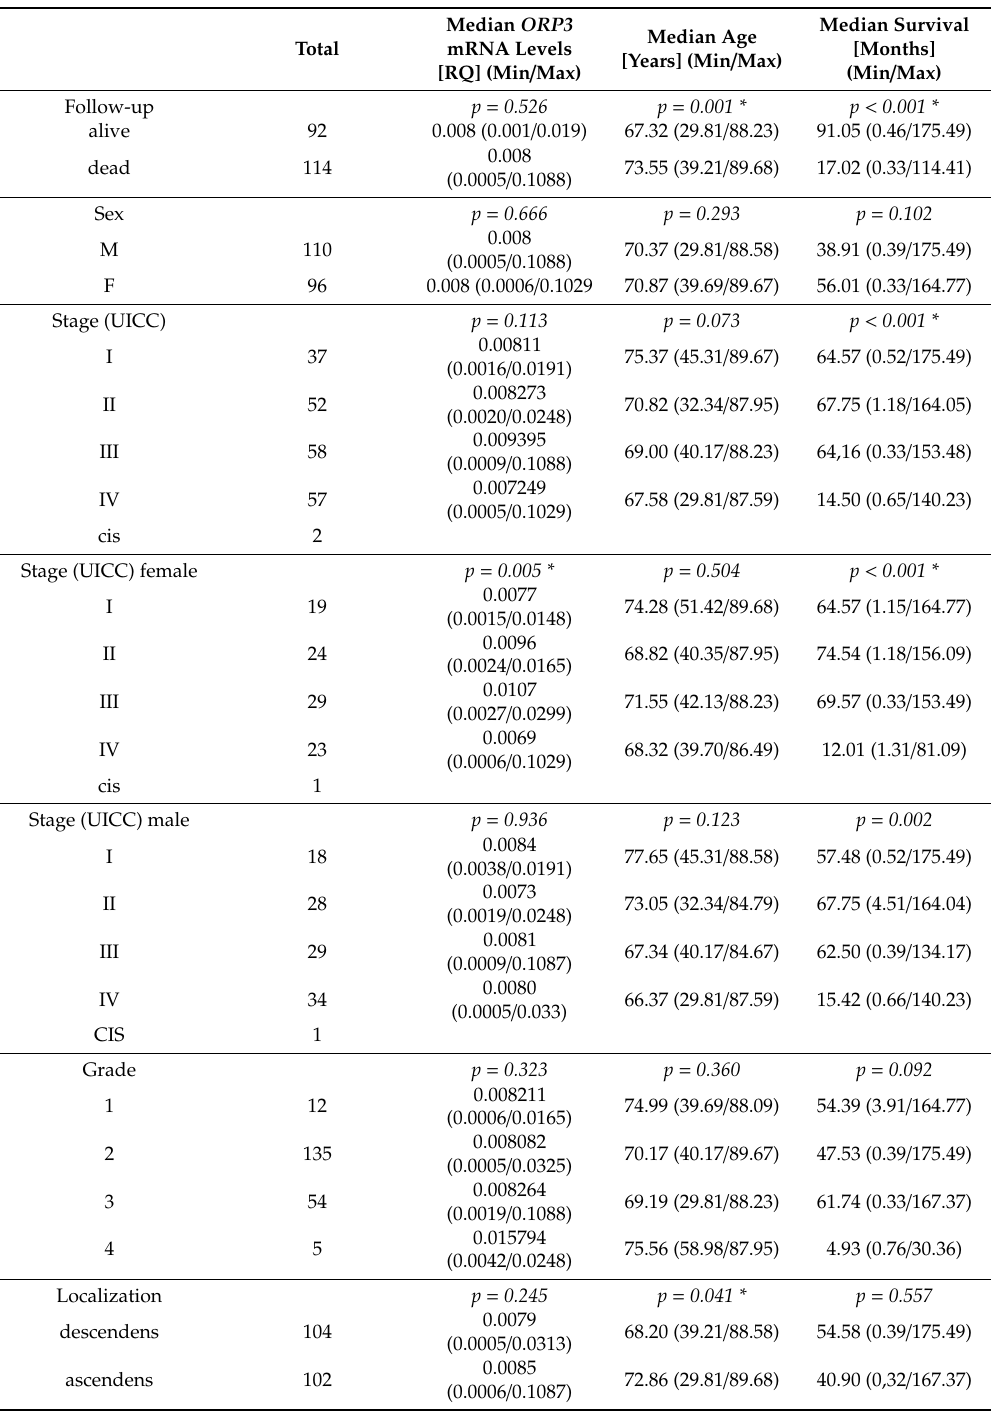
Table 1. Clinical parameters of colon cancer patients’ cohort. Clinical parameters of the colon cancer patients in regard to UICC stage, tumor grade, sex, and localization of tumor within the colon referring to median age, survival and expression level of ORP3 . Expression levels are calculated